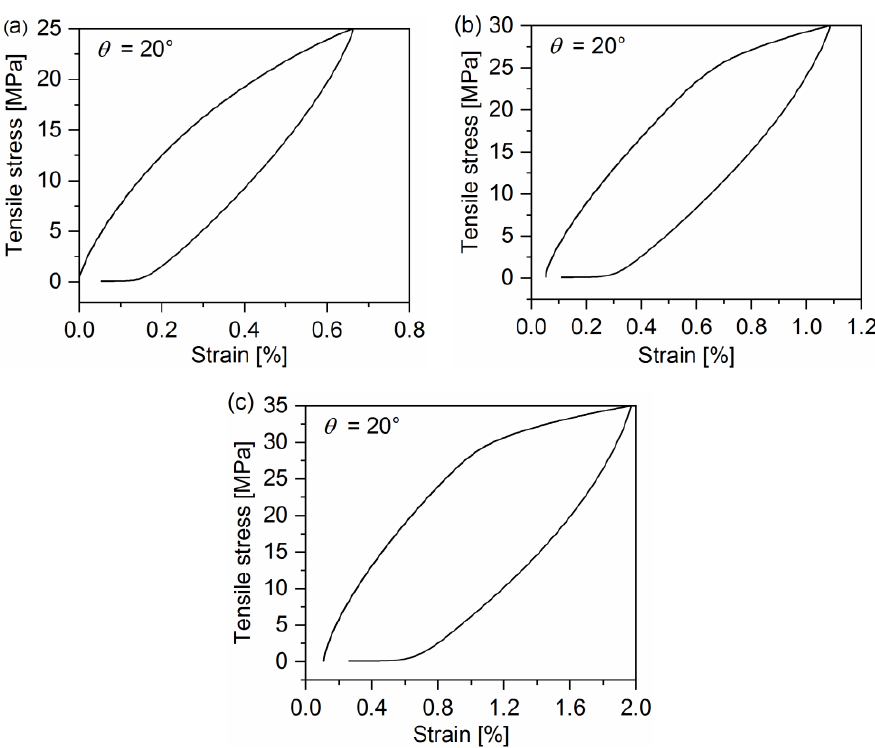
Figure 3. Representative curves from multilevel cyclic loading-unloading recovery tests for the 20° off-axis sample: ( a ) Peak stress: 25 MPa, ( b ) peak stress: 30 MPa, and ( c ) peak stress: 35 MPa.